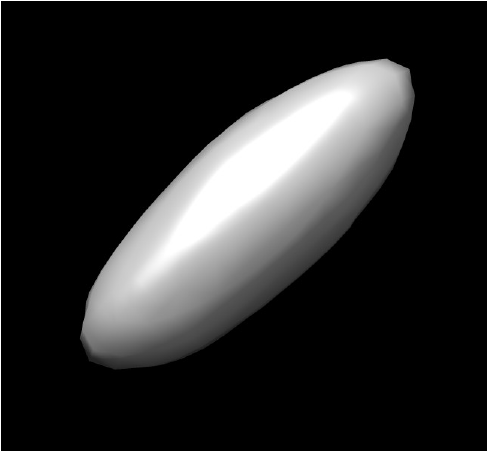
Figure 8. Image reconstructed from two particles per diffraction